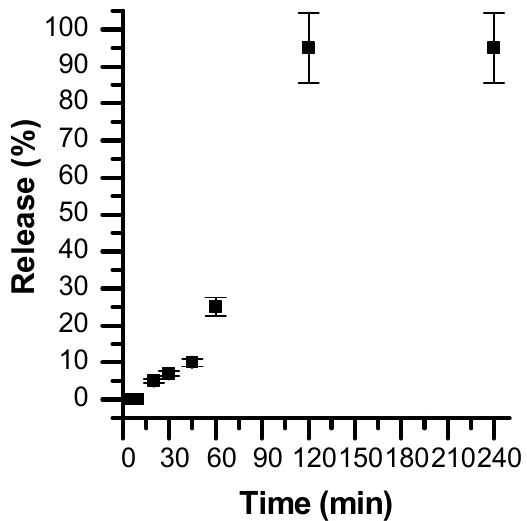
Figure 9. Tocopherol acetate release from CD-CaCO 3 particles at pH 5.